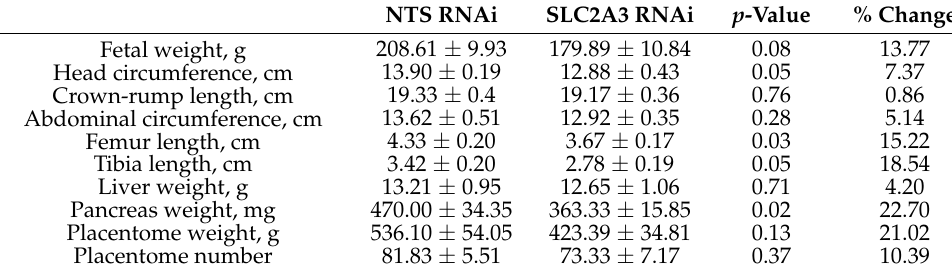
Table 2. Placental and fetal measurements obtained at 75 dGA.